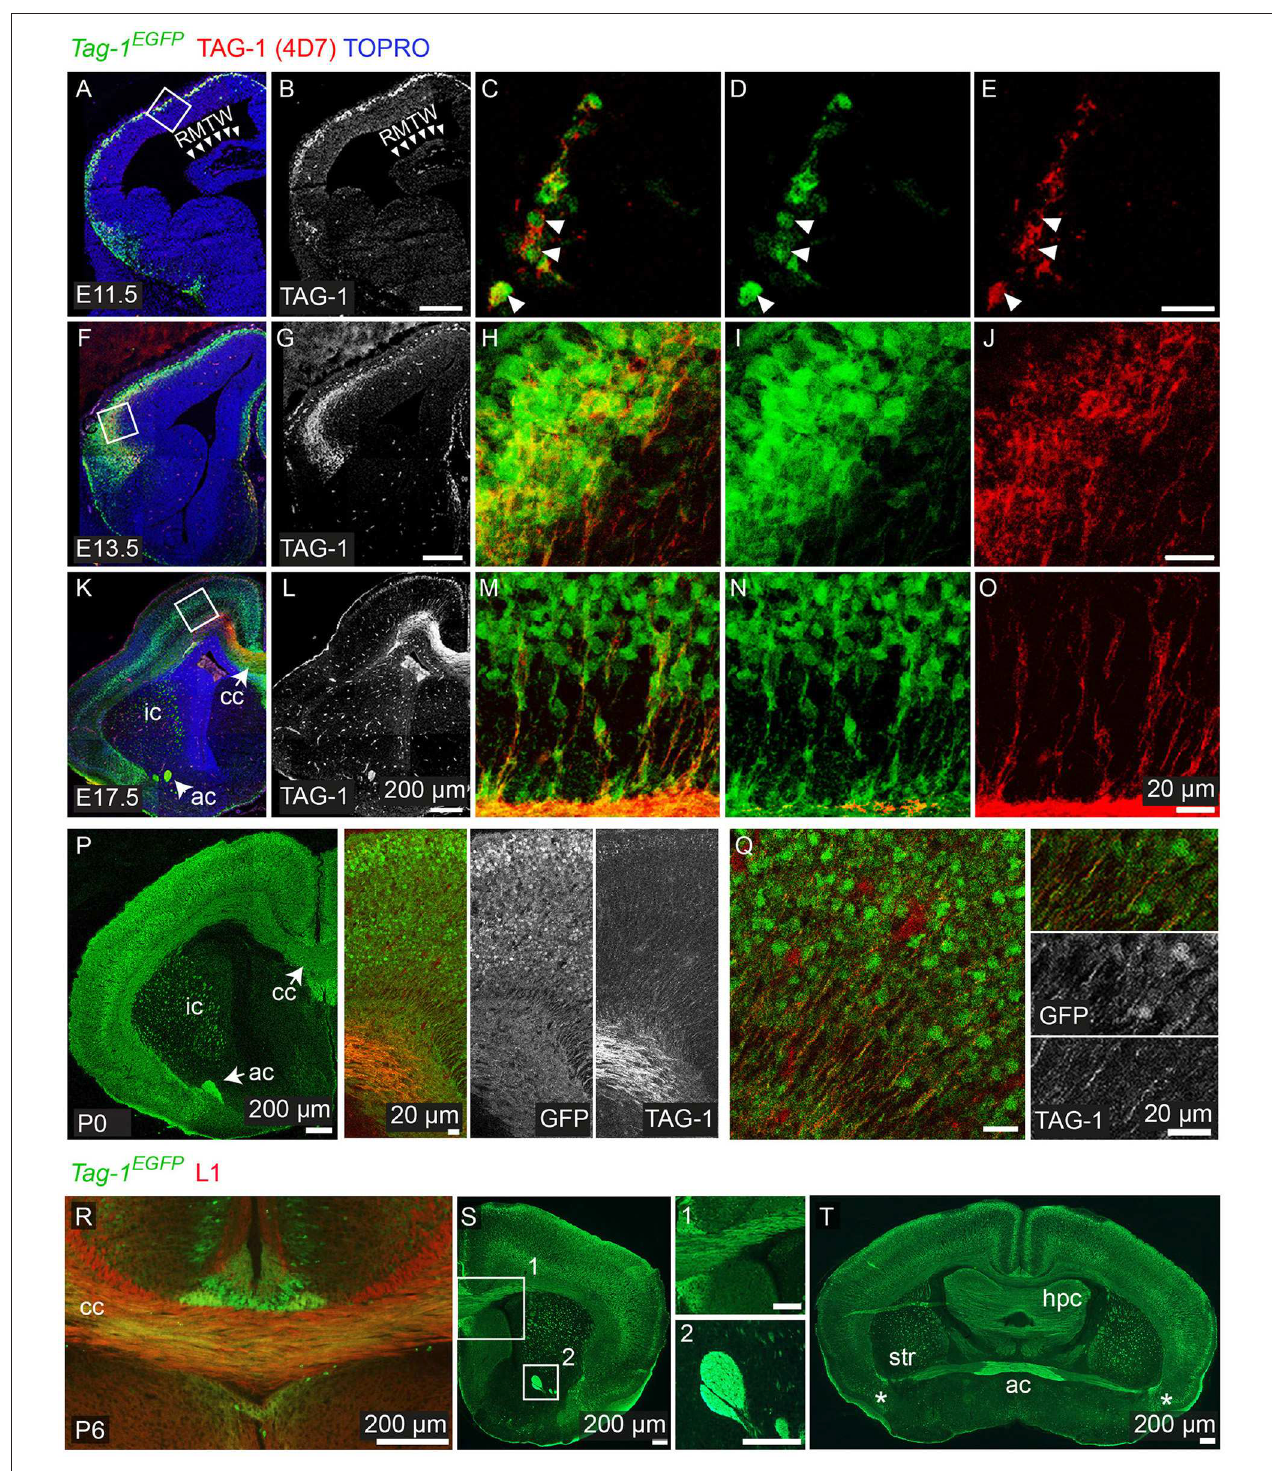
FIGURE 2 | Tag-1 EGFP expression in the developing embryonic and early postnatal cortex. (A–O) Immunofluorescent analysis of Tag-1 EGFP and TAG-1 (clone 4D7) expression in the mouse brain during embryonic stages E11.5 to E17.5. (P,Q) Immunofluorescent analysis of Tag-1 EGFP and TAG-1 (clone 4D7) expression in the newly-born mouse brain. (R–T) Immunofluorescent analysis of Tag-1 EGFP and L1 in P6 mouse brain shows the composition of the corpus callosum and anterior commissure of Tag-1 EGFP + axons. Note the coincidence of EGFP and TAG-1 signal in the cortex and the associated axonal tracts. RMTW, rostromedial telencephalic wall, cc, corpus callosum, ic, internal capsule; ac, anterior commissure, str, striatum, hpc, hippocampus.